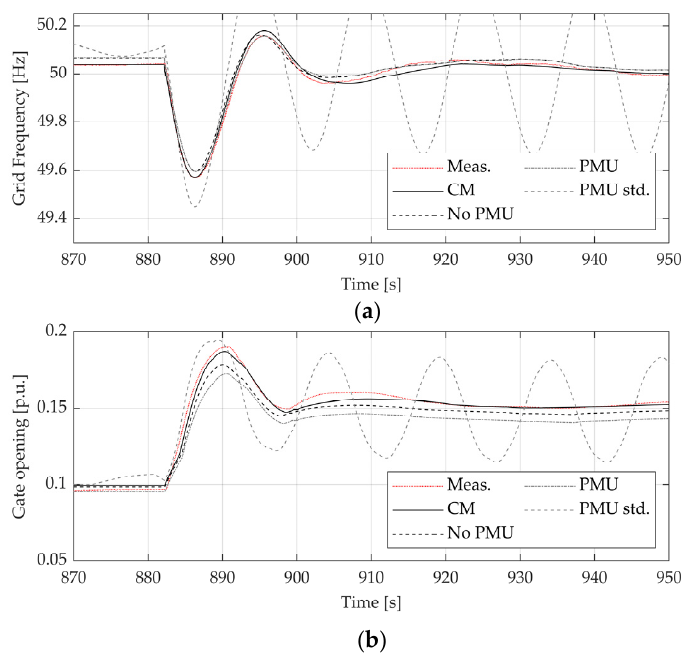
Figure 11. Comparison between simulation results and measurement recordings of the S L1 event for ( a ) the grid frequency and ( b ) the gate opening of G1 for different model of the PMU.